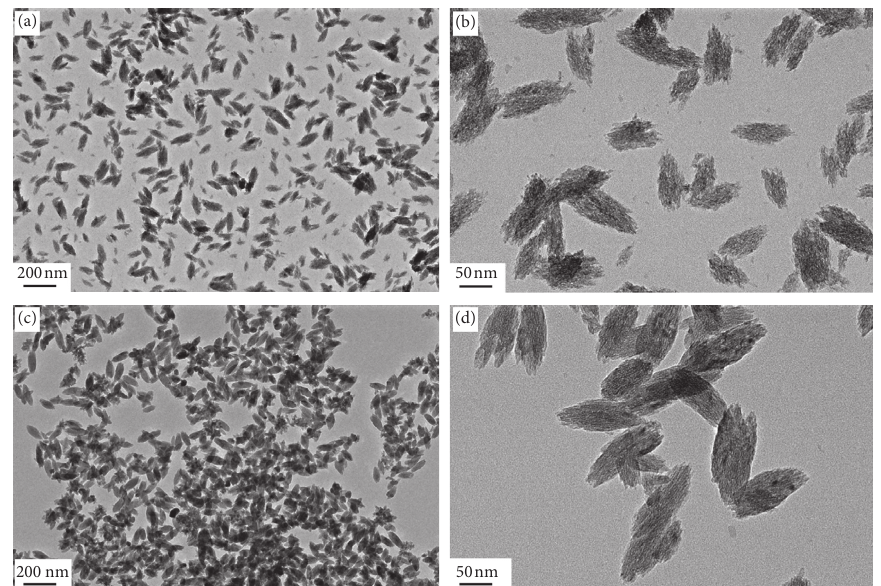
Figure 3: TEM images of YVO � 6.0, and (c), (d) pH � 9.0 through hydrothermal route. 4 nanocrystals produced at (a), (b) pH